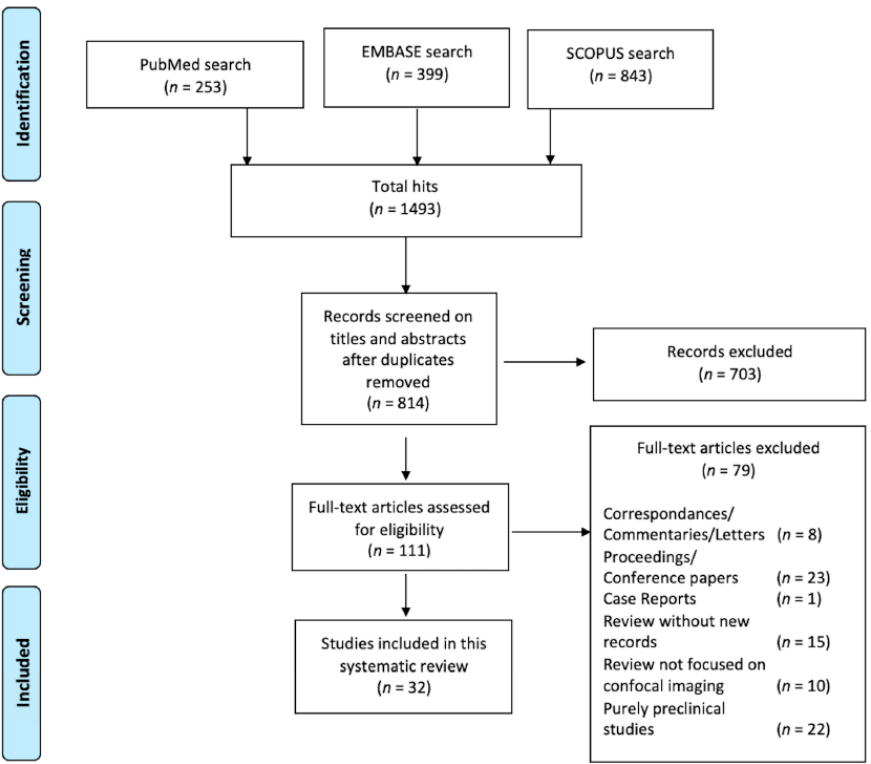
Figure 1. The flowchart of search hits and the different Preferred Reporting Items for Systematic reviews and Meta-analyses (PRISMA)-guideline selection phases, from the initial search and the follow-up search (b), resulting in the total amount of 32 included articles. Table 1. In vivo experiences (7 works). Legend to the table: CLE: confocal laser endomicroscopy; HGGs: high-grade gliomas; iv: intravenously; LGG: low-grade gliomas; SF: sodium fluorescein; 5-ALA: 5-aminolevulinic acid. Fluorophore N . of pts Pathologies Study, Year Confocal System Used Used (Dosages, Protocol)